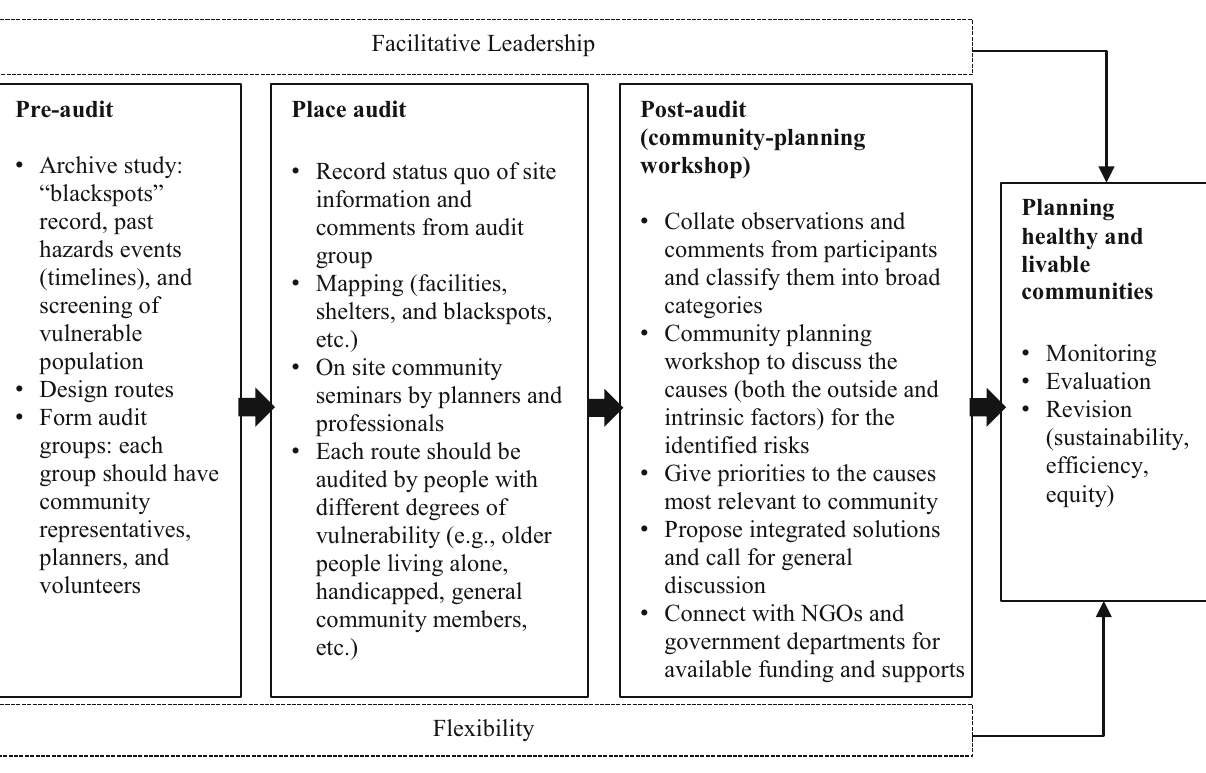
Fig. 1 Framework of collaborative place audit (CPA). Source The